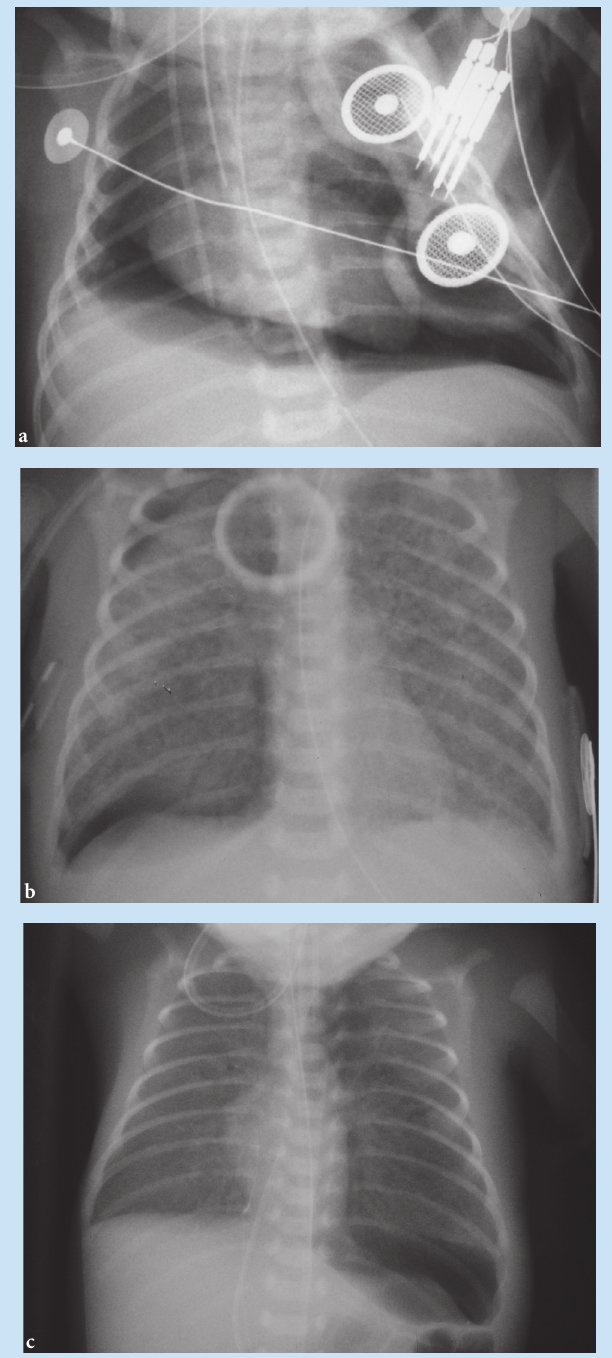
Fig. 10. Complications of ventilation and poor tube position. (a) There is a large pneumomediastinum as a result of barotrauma due to ventilation. This results in the ‘continuous diaphragm sign’. In addition the ETT is low. (b) There is a right-sided pneumothorax in a patient with underlying hya- line membrane disease. The intercostal drain which is present for treating the pneumothorax can be seen with its tip and side holes subcutaneously rather than in the chest cavity. The ring-like density represents a cutane- ous capnography probe. (c) There is an unusually distributed left pneumothorax causing depres- sion of the diaphragm. The umbilical vein catheter has its tip in the right atrium which is considered appropriate for hyperalimentation by some, and at risk for thrombosis by others.